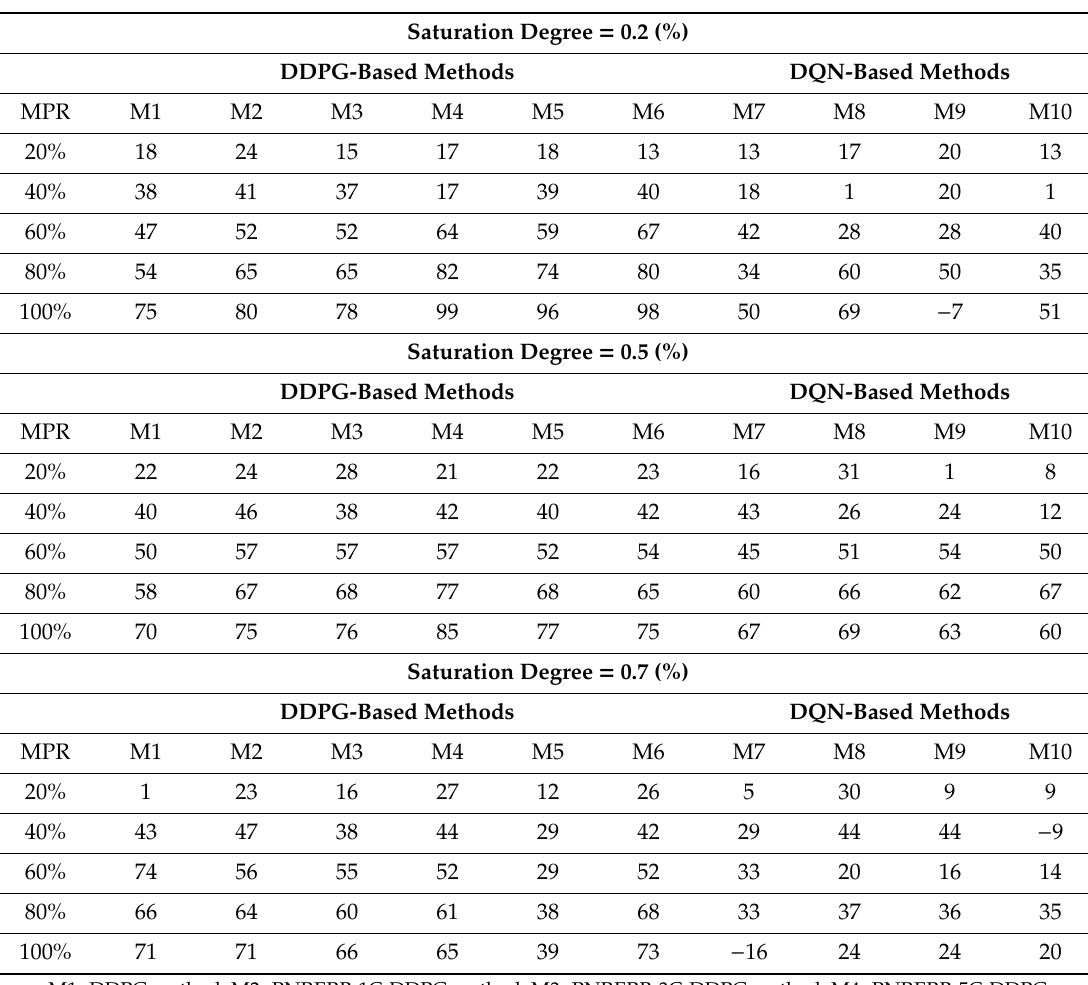
Table 4. Benefits of stop